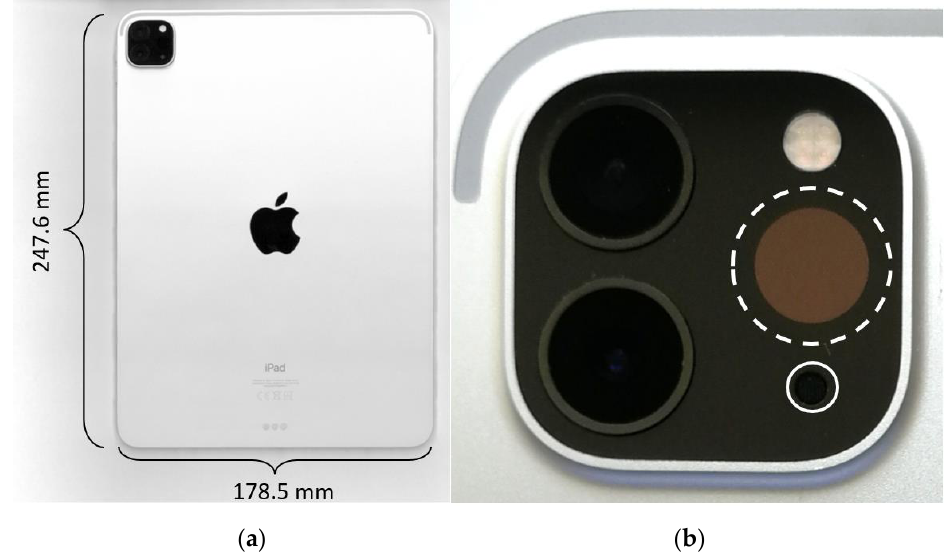
Figure 1. ( a ) iPad Pro 11”, rear view. ( b ) Rear camera cluster with LiDAR module, consisting of SPAD NIR CMOS (single-photon avalanche diode array-based near infra-red complementary metal-oxide-semiconductor image sensor) receptor (circled with white dashed line) and VCSEL DOE (vertical-cavity surface-emitting laser with diffraction optics element) emitter (circled with solid white line).